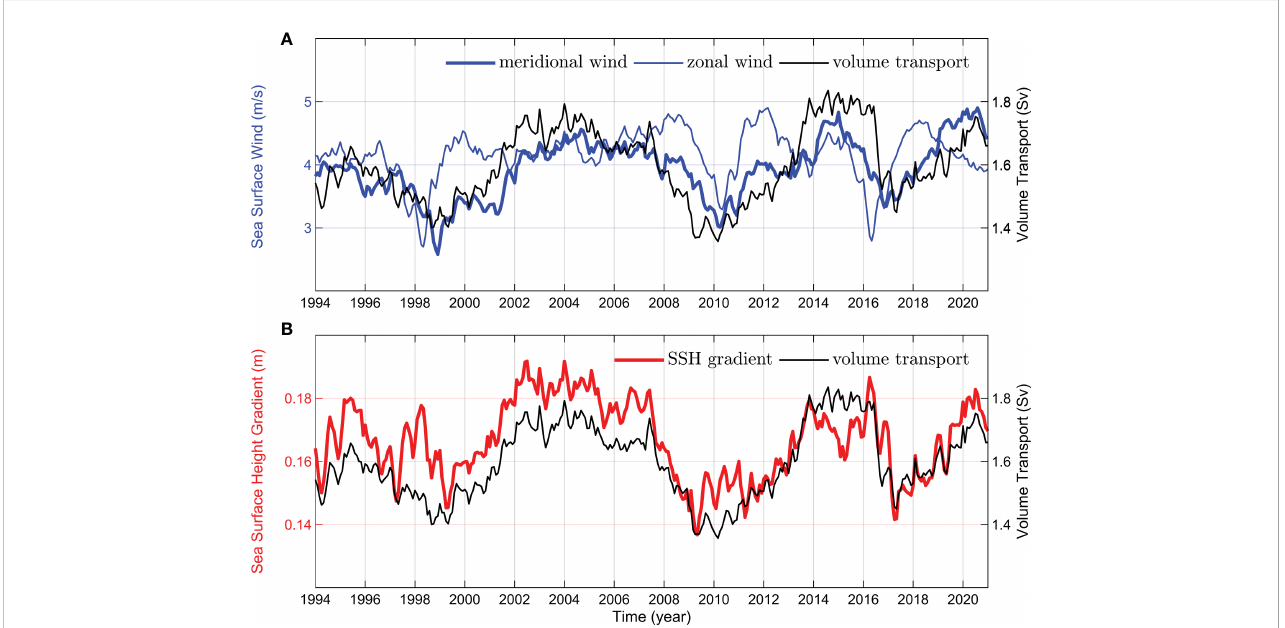
FIGURE 10 (A) Seasonal amplitudes of local meridional (blue thick line) wind fi eld, zonal (blue thin line) wind fi eld and volume transport (black solid line) obtained by harmonic algorithm (Method 2). (B) Seasonal amplitudes of SSH gradient (red solid line) and volume transport (black solid line) obtained using the harmonic algorithm (Method 2).